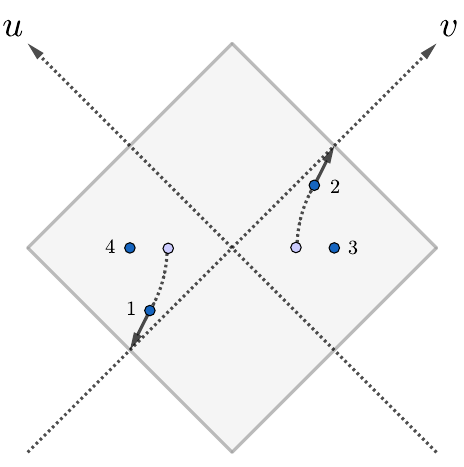
Figure 1 . The Regge con(cid:12)guration of four